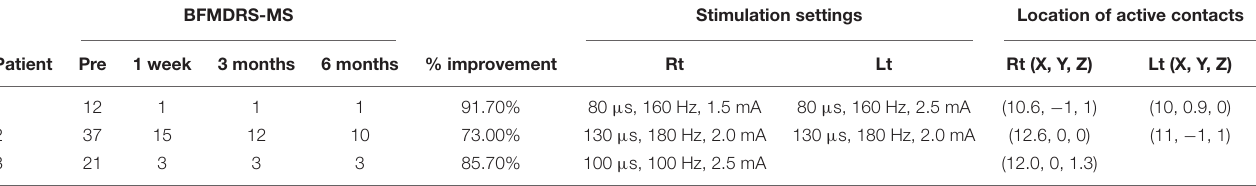
TABLE 2 | Clinical outcomes and stimulation